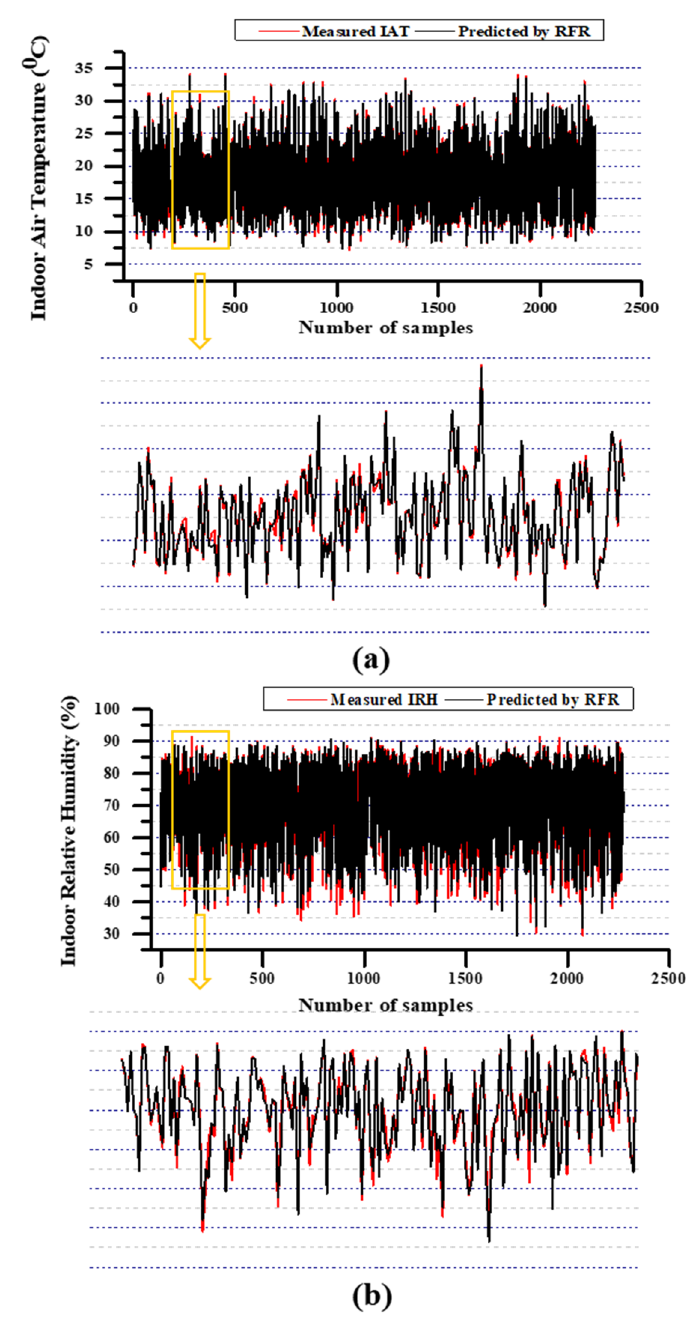
Figure 10. The comparison results between actual and simulated by RFR with S3 for ( a ) IAT prediction ( b ) IRH prediction including the zoomed view from the simulation results.